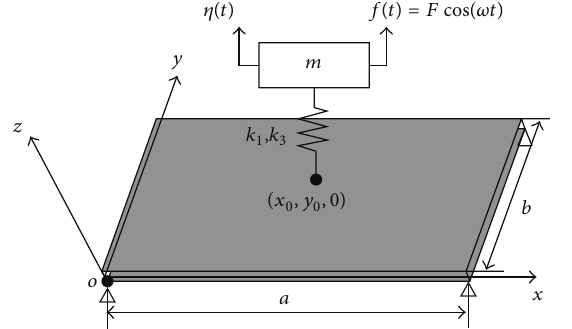
Figure 1: Vibroacoustic model of the plate under a nonlinear oscillator’s